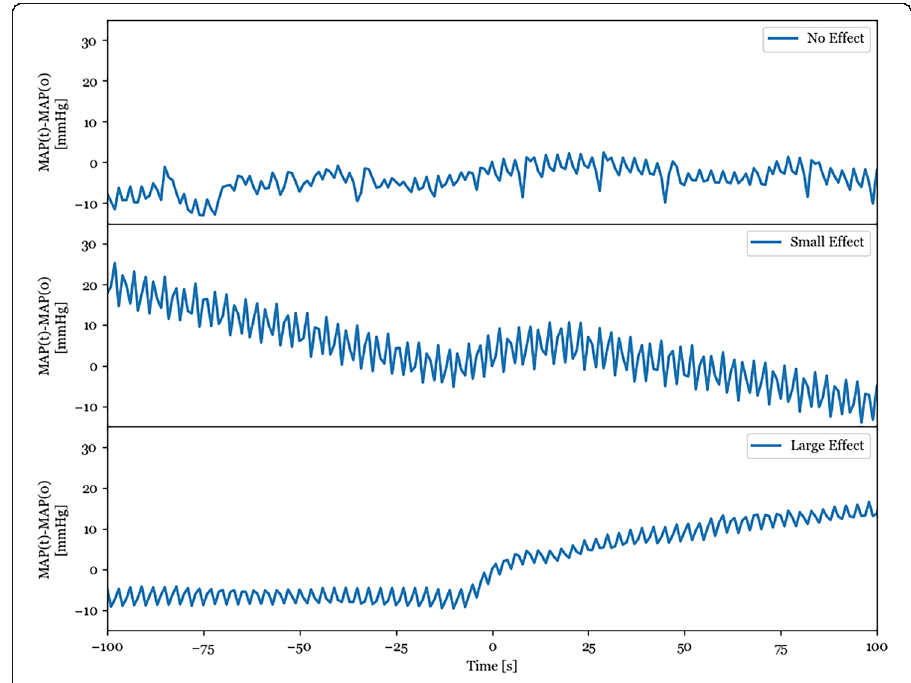
Fig. 3 There are a variety of individual responses to a calcium bolus. The top subplot shows a calcium injection that has no observable effect on the mean arterial pressure. The middle subplot shows a calcium injection that has a modest effect on the mean arterial pressure, but the MAP resumes its decline after about 20 s of improvement. The bottom subplot shows a calcium injection that has a large effect on arterial pressure where the MAP improves due to the calcium bolus and then continues to improve and stabilize as a function of time. These tracings were chosen to represent the spectrum of observed responses